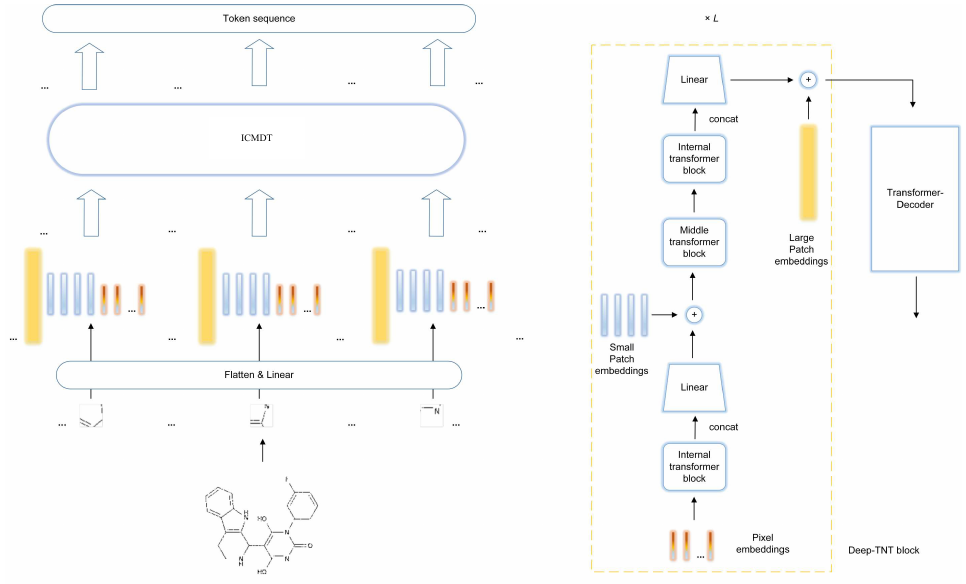
Figure 2. Simplified processing flow of the molecular translation task and the structure of